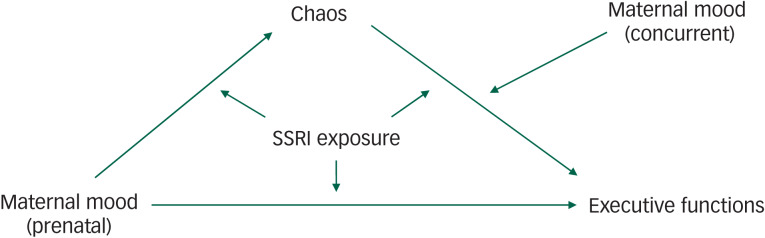
Graphic representations of the competitive-confirmatory model and relationships between the different elements affecting child executive functions at 6 years of age.